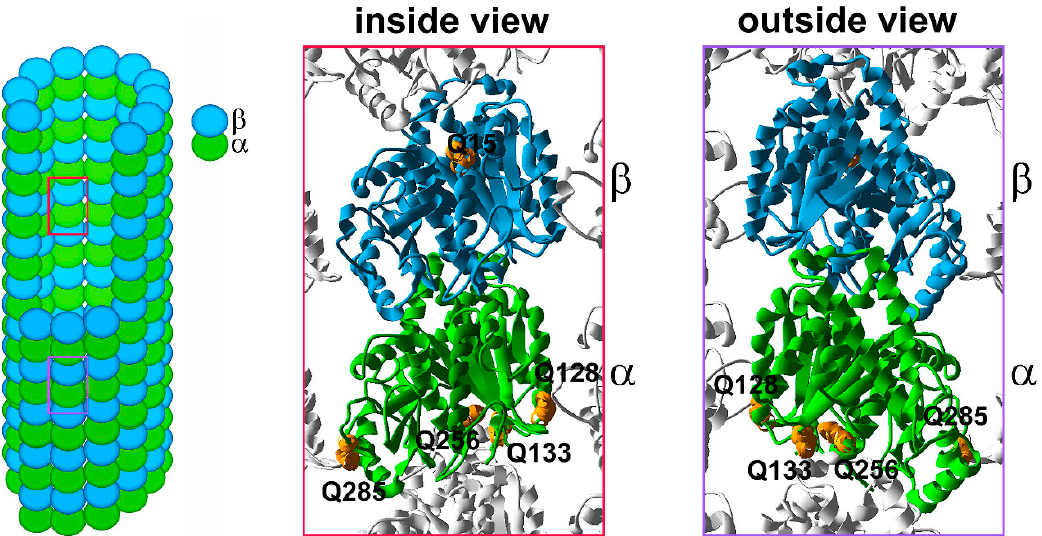
Figure 1. The distribution of the polyamination sites in α , β -tubulin heterodimer. Schematic representation of a microtubule, composed of α - (green) and β - (blue) tubulin heterodimers. Red and purple frames mark tubulin heterodimer with either a visible luminal side (an inside view) or outer surface (outside view), respectively. An inside and outside views of 3D model of the tubulin heterodimer within the microtubule lattice based on 3J6F.pdb (NCBI database); a tubulin molecule is composed of 12 α -helices (numbered H1–H12) and 10 β -strands (numbered S1–S10) linked by loops [8,9]. Putative tubulin polyamination sites are marked in orange. α -Tubulin Q128 is located within the H3–S4 loop and builds the H3 surface, which is involved in lateral interactions with the neighboring protofilament (an outside view, protofilament to the left). α -Tubulin Q285 is located within the S7–H9 loop, the so-called M loop, which is also responsible for lateral interactions with the neighboring protofilament (an outside view, protofilament to the right). α -Tubulin Q133, located within the H3–S4 loop and Q256 located within the H8 helix, build the minus end surface, responsible for longitudinal interactions between heterodimers within the same protofilaments or with γ -tubulin at the nucleation site. Q15 of β -tubulin is located within the H1 helix, positioned near the nucleotide binding pocket.